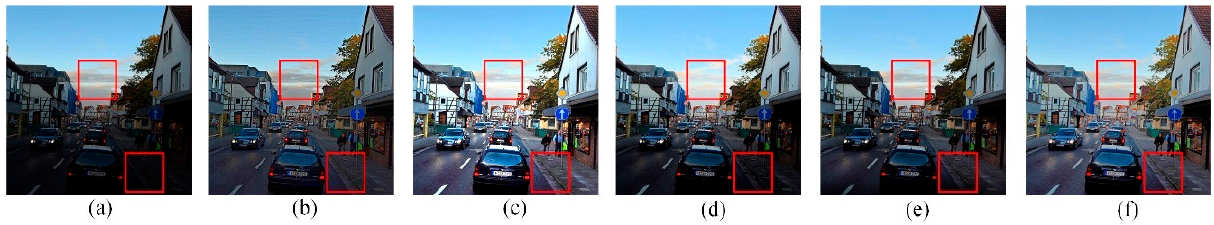
Figure 20. Street image. ( a ) Original image; ( b ) result of Lee’s method; ( c ) result of LIME; ( d ) result of AGCWD; ( e ) result of SIRE; ( f ) result of the proposed method.